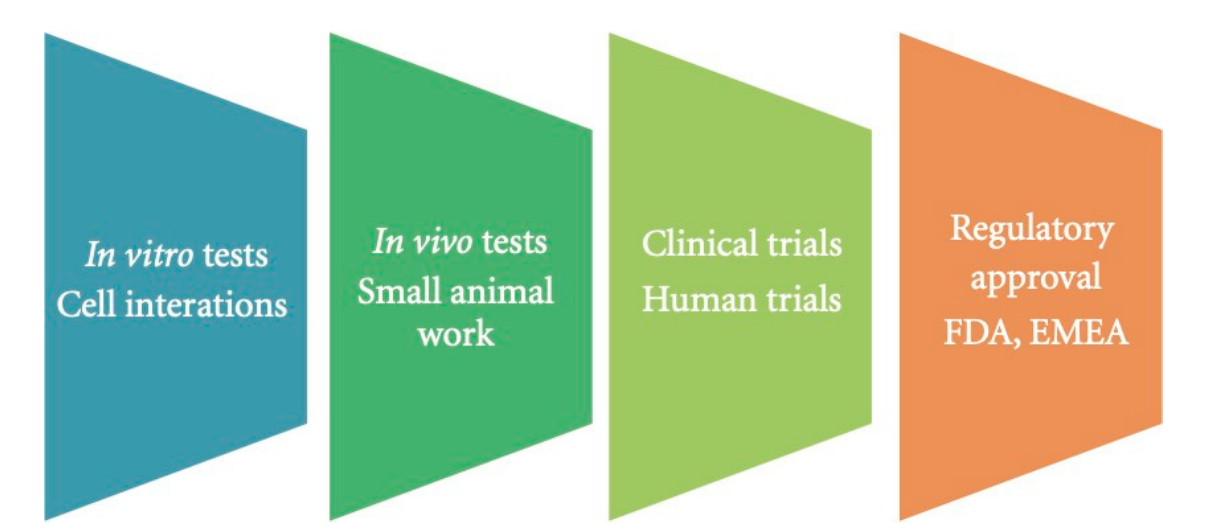
Figure 6. A representation of the clinical trial process [29].